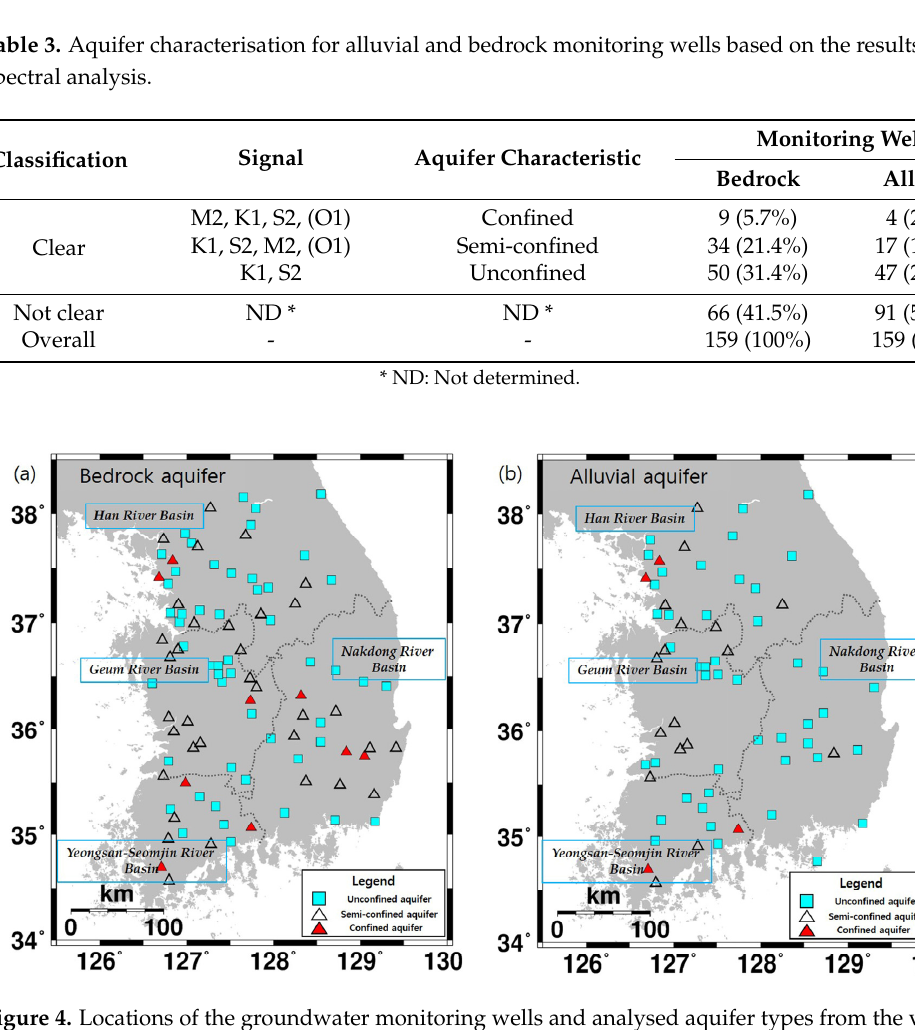
Figure 4. Locations of the groundwater monitoring wells and analysed aquifer types from the various signal components: ( a ) bedrock aquifer; and ( b ) alluvial aquifer.